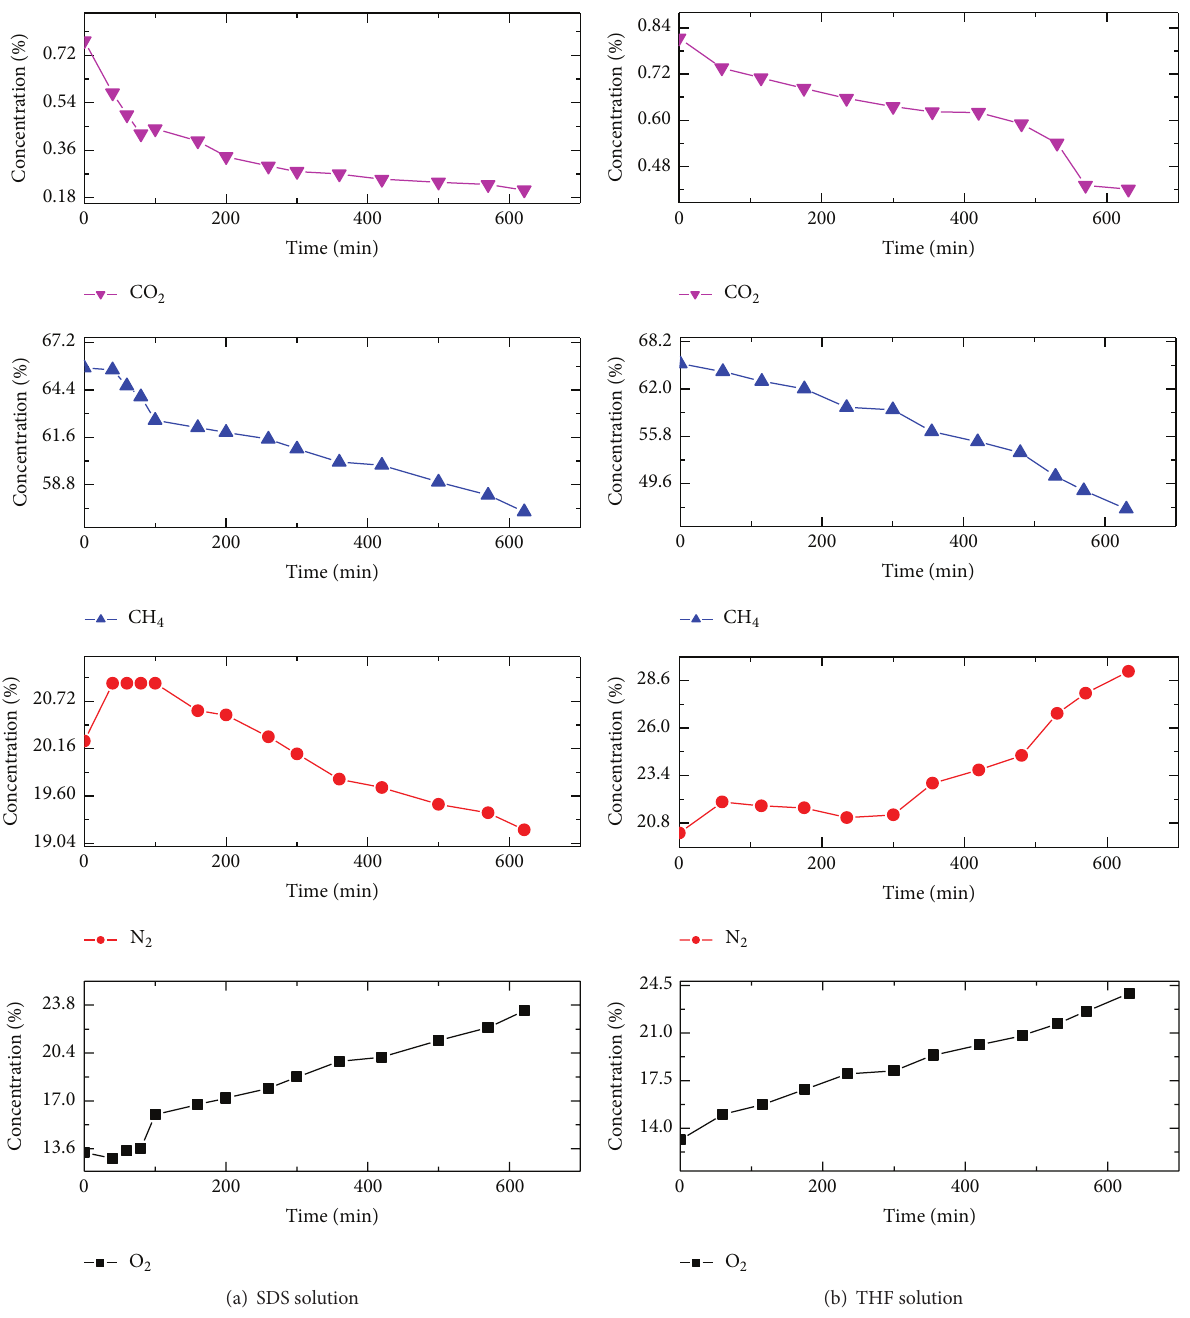
Figure 6: Gas concentration of hydrate formation in SDS and THF